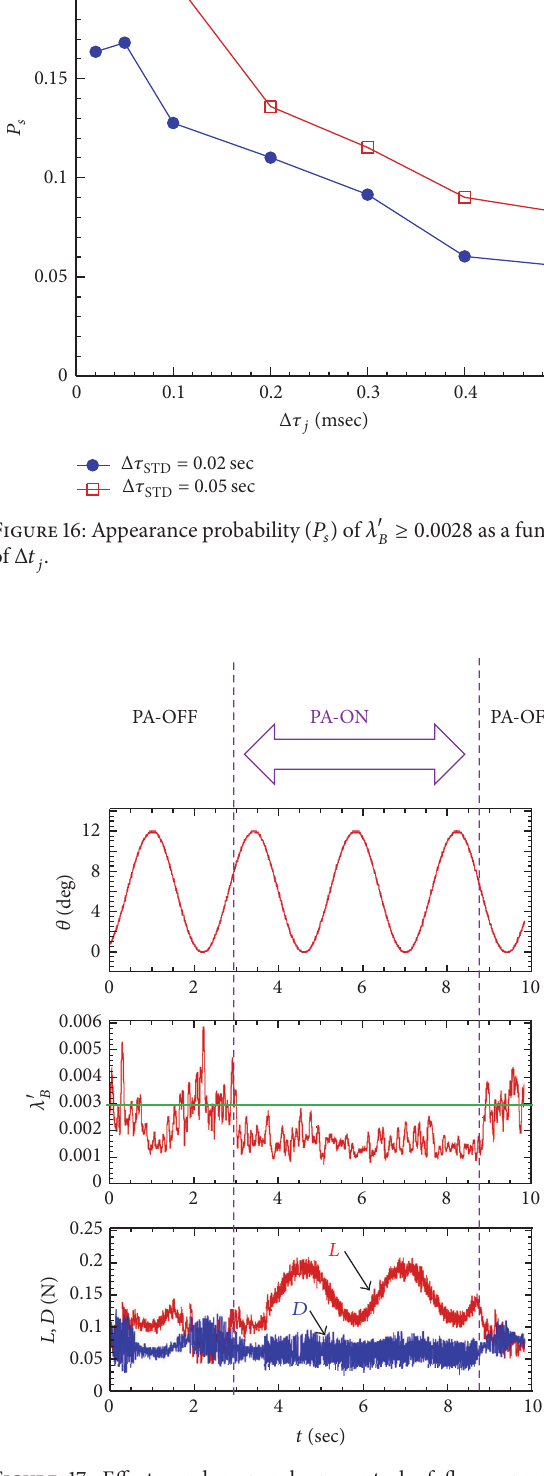
Figure 17: Effects under open-loop control of flow separation. Tangential jets induced by the string-type DBD plasma actuator was injected continuously in 3.0 ≤ 𝑡 ≤ 9.0